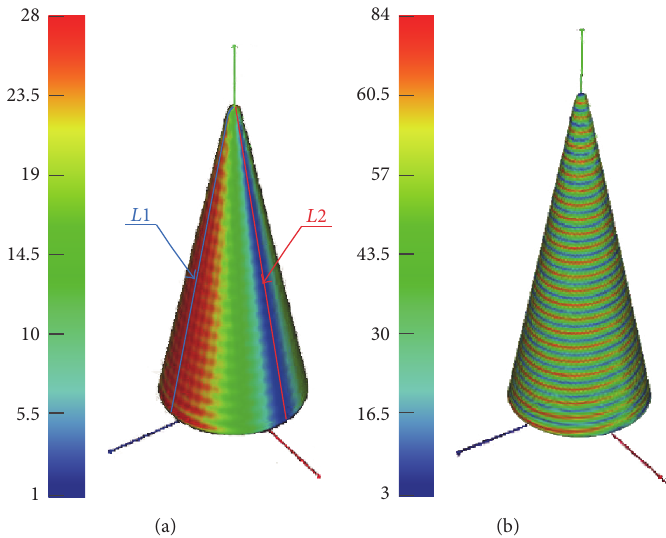
Figure 2: Induced currents on the flank of the cone. (a) Amplitude; (b) phase.